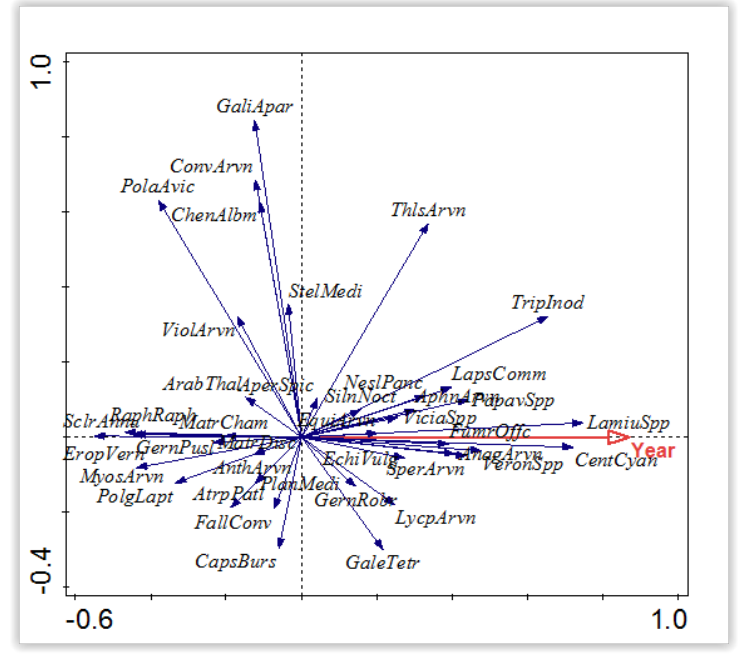
Figure 4. Temporal trends in species composition in Pernolec at plots treated with synthetic auxins. Ordination diagrams of partial Redundancy Analysis (RDA). Year is the explanatory variable and crop type is the covariate; species with low weight are not shown.